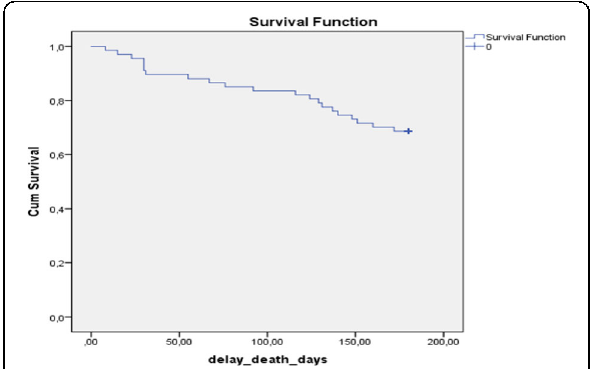
Fig. 2 (abstract 001386). kaplan Meier survival in elderly ICU